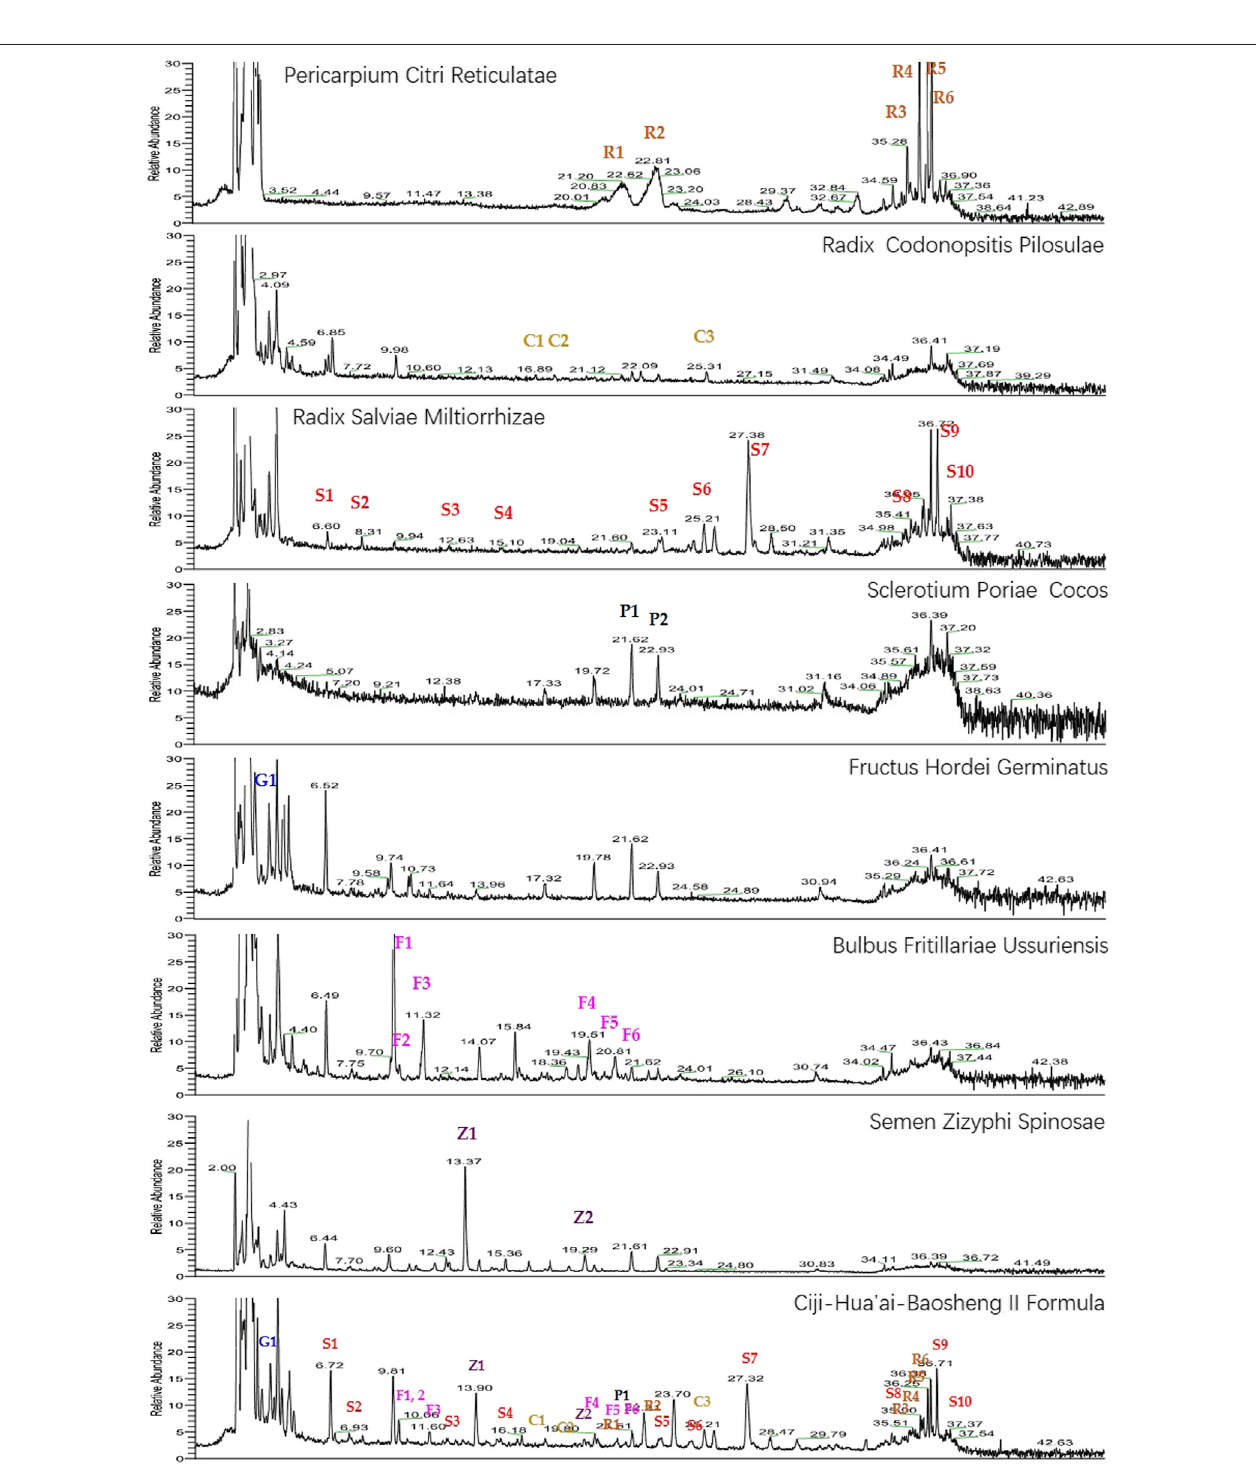
FIGURE1| UHPLC-MSchemical fi ngerprintchromatogramofCHB-II-Fandeachherb.Naringin(R1),hesperidin(R2),5,7,8,4 ′ -tetramethoxy fl avone(R3),nobiletin (R4),3,5,6,7,8,3 ′ ,4 ′ -heptamethoxy fl avone(R5), tangeretin (R6),phenylalanine(S1), salvianolicaid A(S2),protocatechualdehyde (S3),caffeic acid(S4),lithospermicacid (S5), rosmarinic acid (S6), salvianolic acid B (S7), tanshinone IIA (S8), cryptotanshinone (S9), dihydrotanshinone I (S10), tangshenoside I (C1), tangshenoside II (C2), kukoamine B (C3), thalictrine (Z1), spinosin (Z2), nicotinic acid (G1), pingpeimine B (F1), pingpeimine A (F2), pingpeimine C (F3), peimisine (F4), peimine (F5), and peiminine (F6).